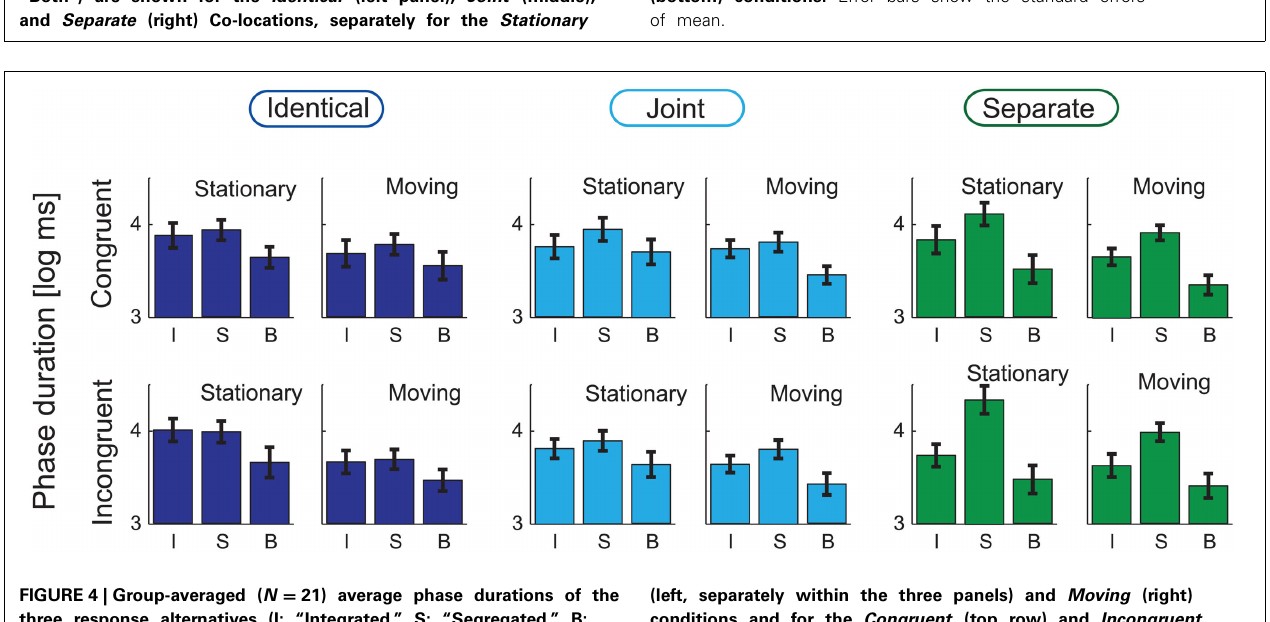
FIGURE 4 | Group-averaged ( N = 21) average phase durations of the three response alternatives (I: “Integrated,” S: “Segregated,” B: “Both”) are shown for the Identical (left panel), Joint (middle), and Separate (right) Co-locations, separately for the Stationary